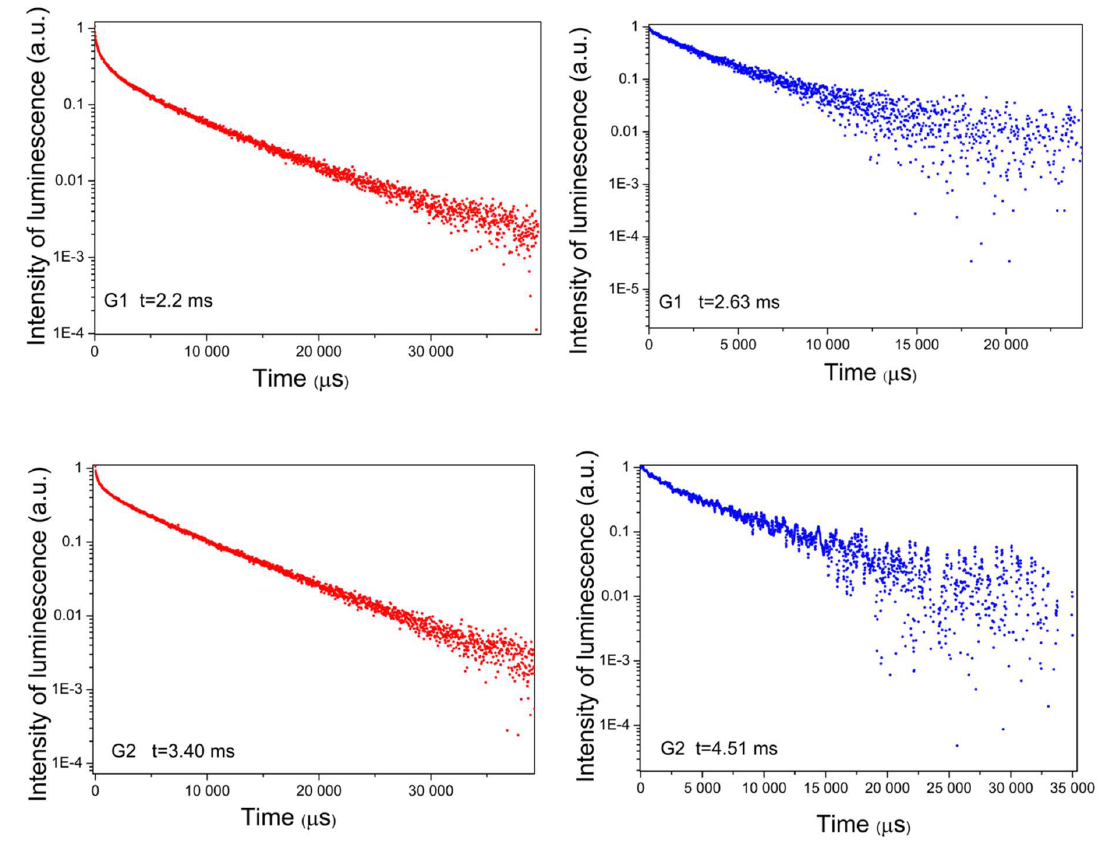
Figure 7. Luminescence decay curves for genthelvite samples G1 and G2 measured at T = 300 K and T = 77 K (red and blue line, respectively).